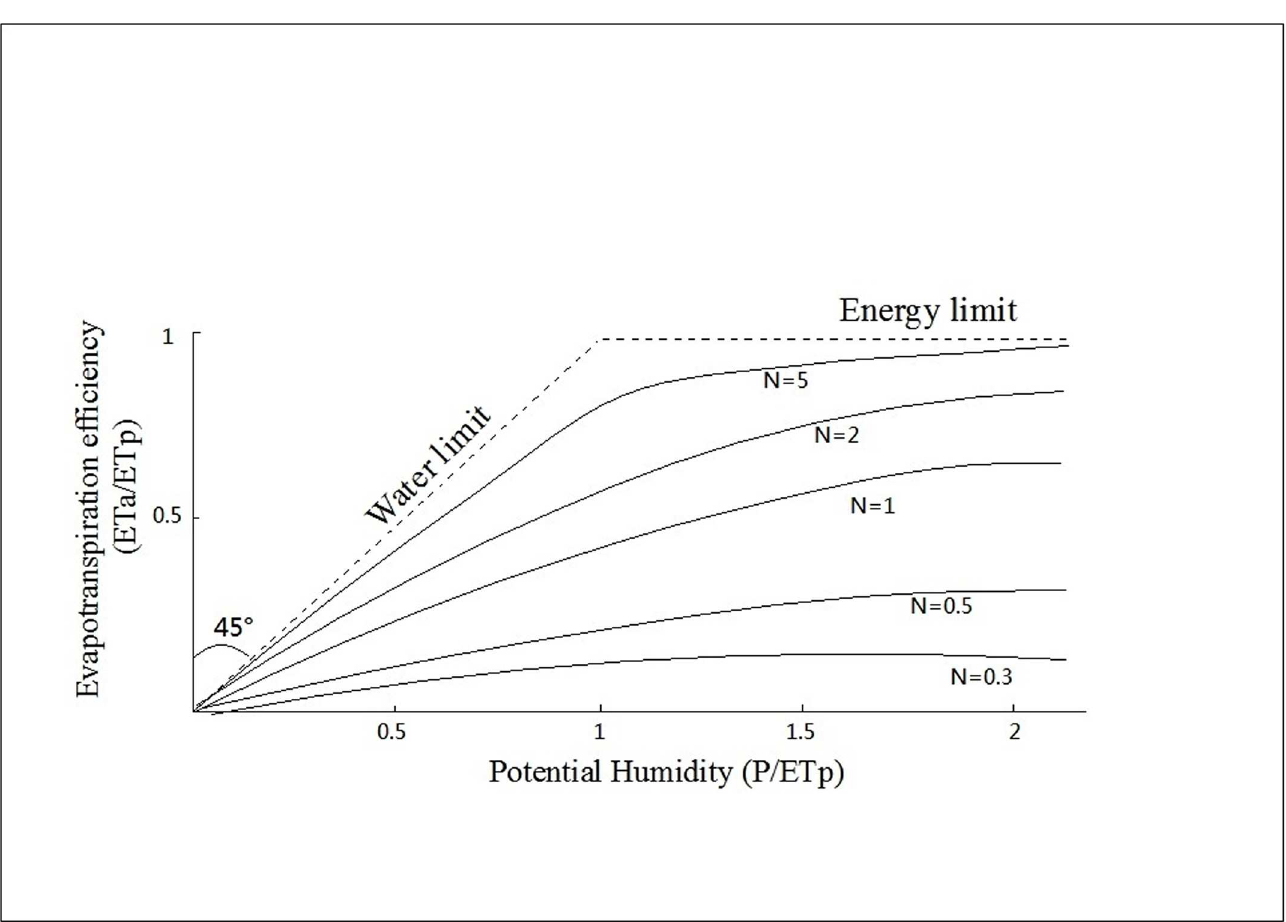
Fig 2. The spatial distribution of the mean annual precipitation in the rocky desertification areas in South China from 2000~2013.